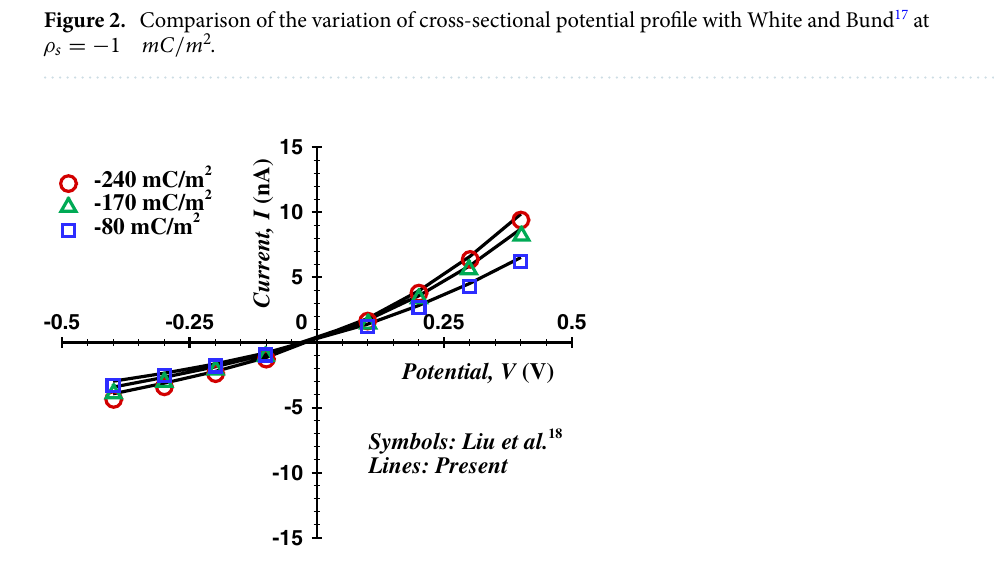
Figure 3. Comparison of the variation in average current with applied voltage for a bulk concentration of KCl at 0.05 M with Liu et al. 18